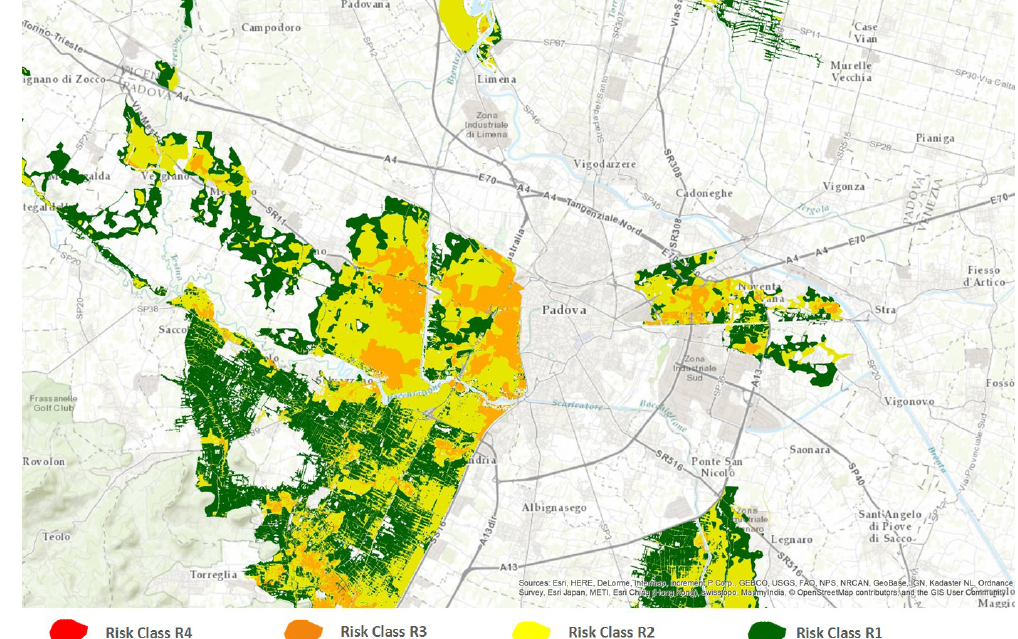
Figure 7. Risk map for the metropolitan area of Padua for a 100-year flood event after implementation of a CO on flood risk management. Sources: Esri, HERE, DeLorme, Intermap, Increment P. Corp., GEBCO, USGS, FAO, NPS, NRCAN, GeoBase, IGN, Kadaster NL, Ordnance Survey, Esri Japan, METI, Esri China HongKong, swisstopo, MapmyIndia, © OpenStreetMap contributors 2020. Distributed under a Creative Commons BY-SA License and the GIS user community.